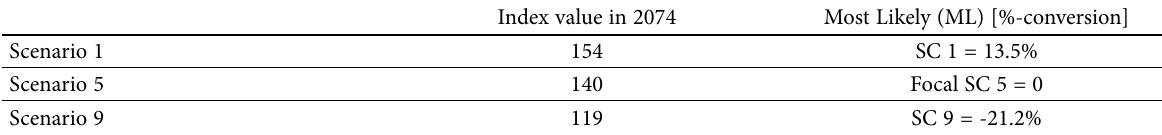
Table 8. Conversion of scenario trend development values